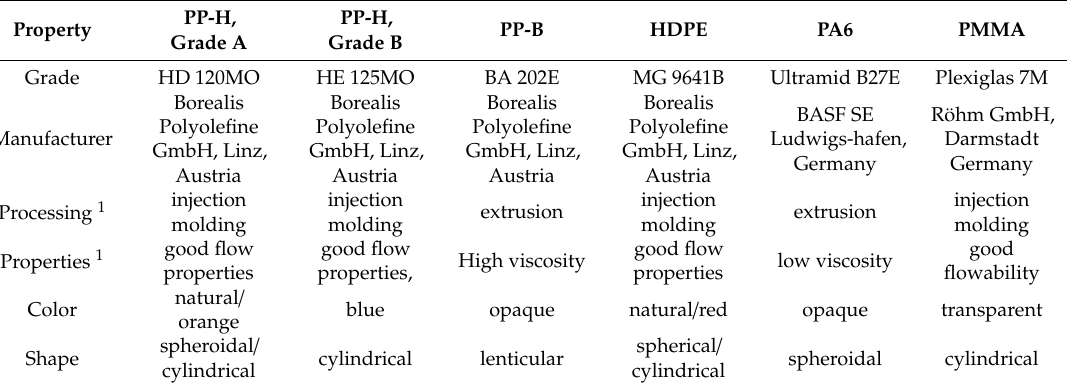
Table 3. Properties of the materials used.